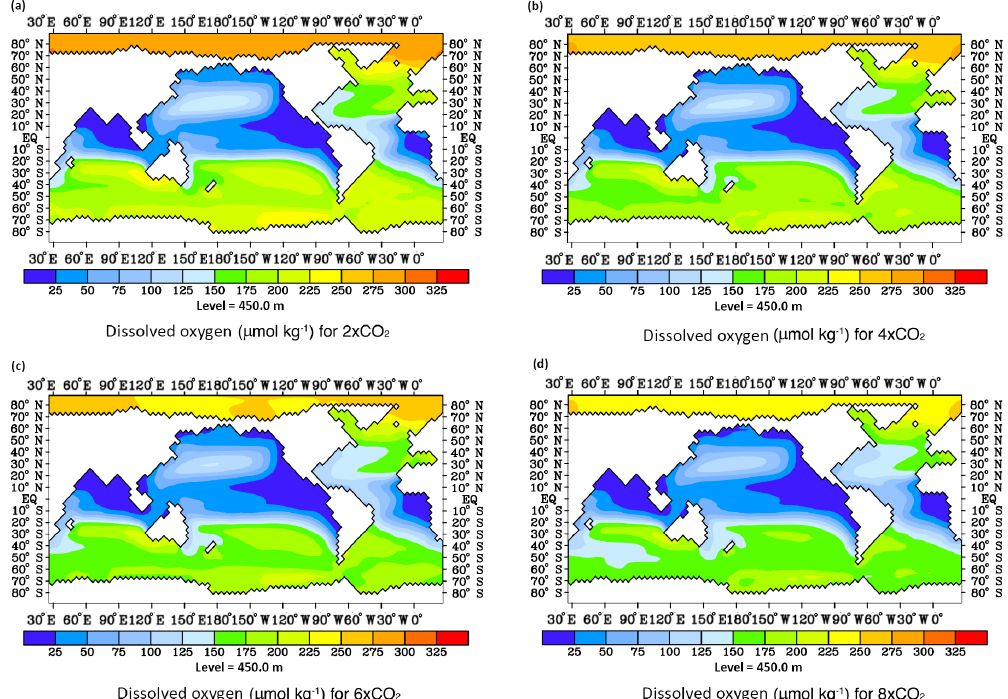
Figure 6. The horizontal expansion of OMZs at 450m depth for the Pacific, Atlantic and Indian oceans in the (a) 2 × CO 2 simulation, (b) 4 × CO 2 simulation, (c) 6 × CO 2 simulation and 8 × CO 2